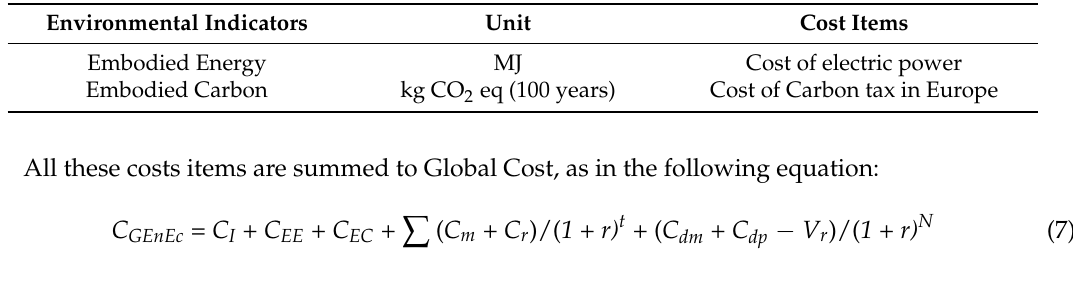
Table 4. Summary table of Embodied Energy and Embodied Carbon indices and relative cost